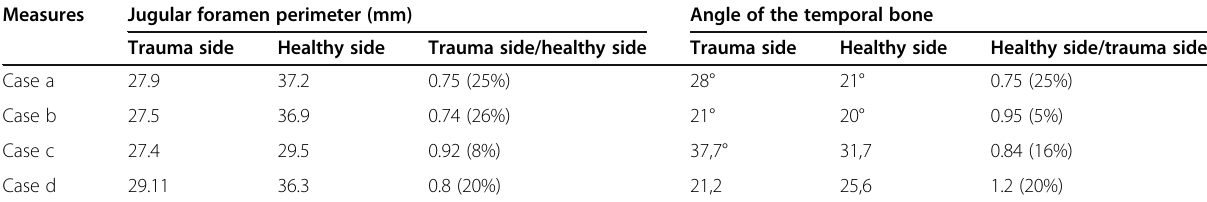
Table 3 Measures of asymmetry skull base